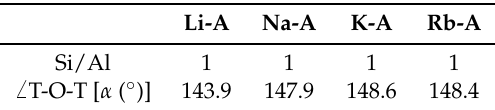
29 Si NMR data: Si/Al ratios and average T-O-T bond angles for Li, Na, K and Rb-A. The angular values are estimated based on NMR data using the regression relationship from [36], and we estimate the accuracy on angles up to ± 2 degrees.